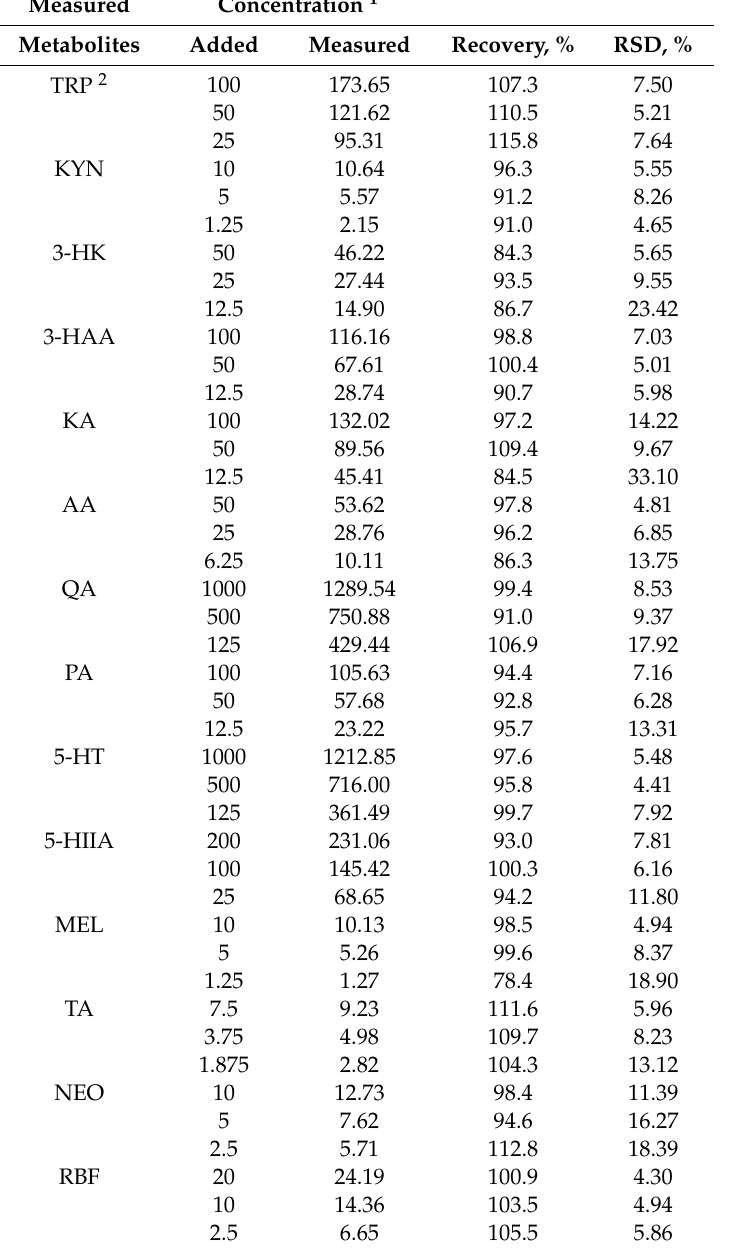
Table A3. Analytical recovery of the